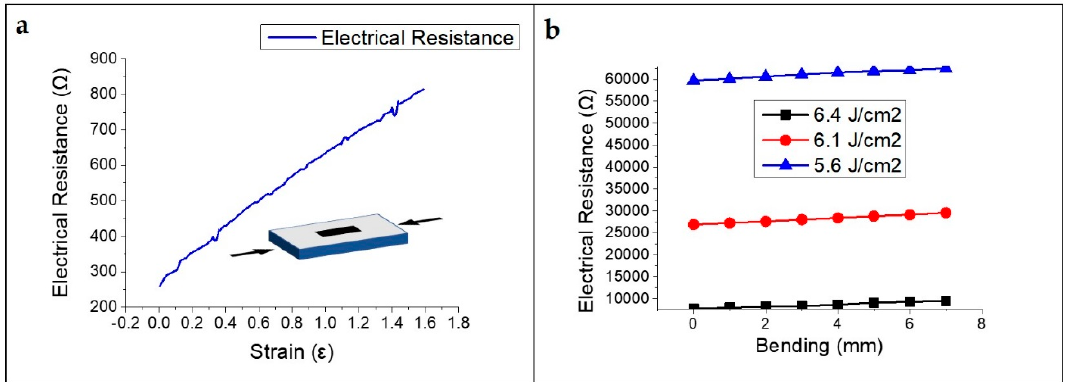
Figure 7. Change in electrical resistance corresponding to strain with each laser fluence: ( a ) 7.4 J/cm 2 ; ( b ) 5.6 to 6.4 J/cm 2 .